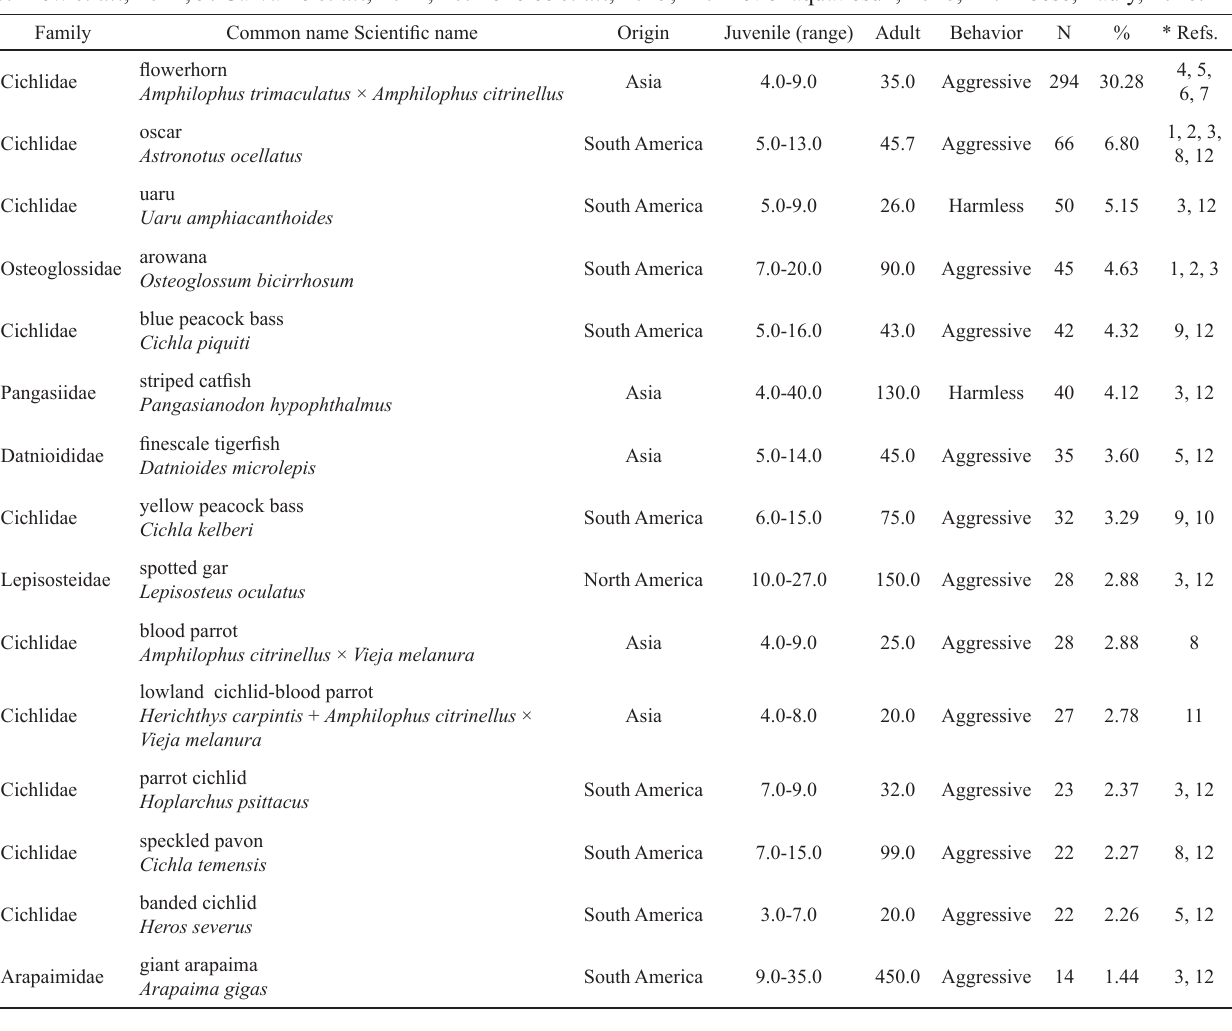
Tab. 1. Top 15 non-native large fishes available in the unregulated market, monitored between May-2012 and September-2016. The table shows information about family, common/scientific name, native origin, juvenile and maximum adult length (cm), aggressiveness, number of specimens available (N) and their relative frequency (%). * References - 1: Axelrod, 1992; 2: Sandford, Crow, 1996; 3: Axelrod et al ., 2005; 4: Nico et al ., 2007; 5: Ng, Tan, 2010; 6: Herder et al ., 2012; 7: Jaafar et al ., 2012; 8: Liew et al ., 2012; 9: Carvalho et al ., 2014; 10: Pelicice et al ., 2015; 11: Motionaquaticsuk, 2016; 12: Froese, Pauly,